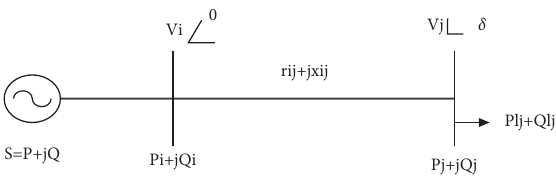
Figure 1: Single line diagram of the two-bus system for